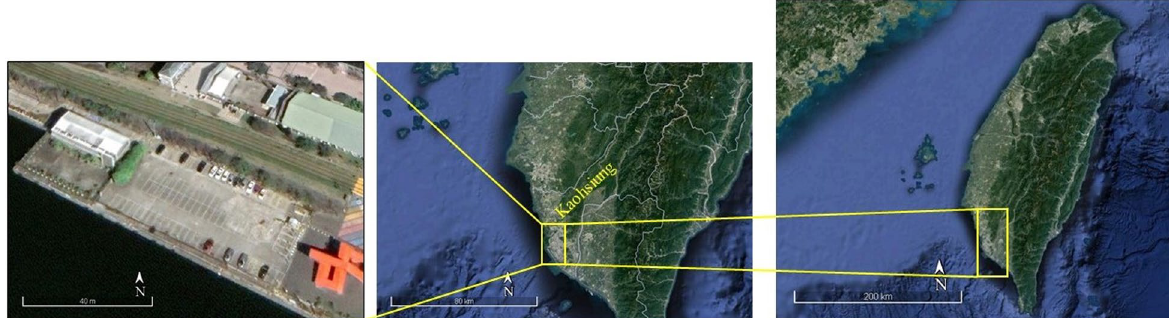
Figure 1. Geographical location of the studied site in Kaohsiung, Taiwan (Google Earth Pro 7.3.3.7786 (2021)).